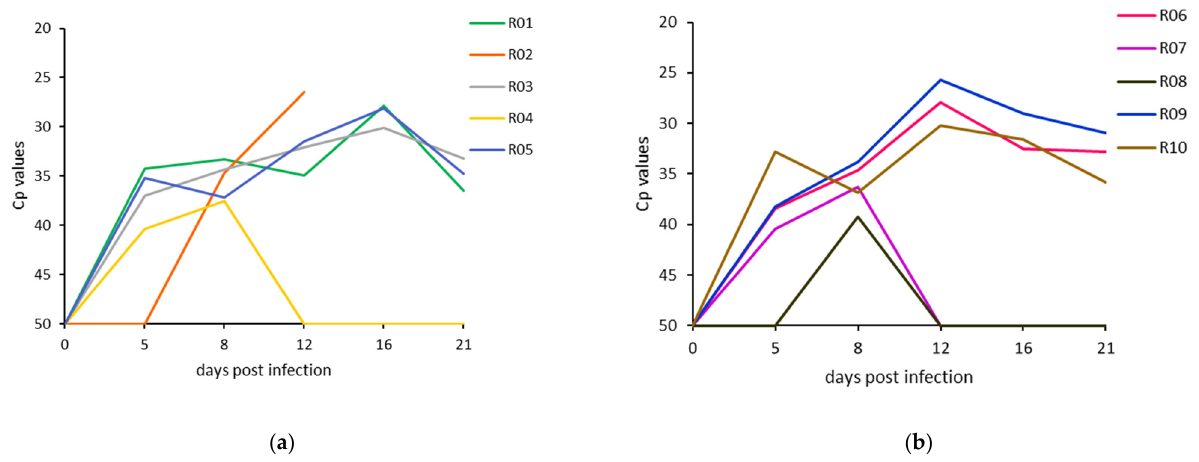
Figure 5. Real-time PCR Cp values for EDTA blood for each animal in ( a ) experiment 1 and ( b ) experiment 2 on consecutive sampling